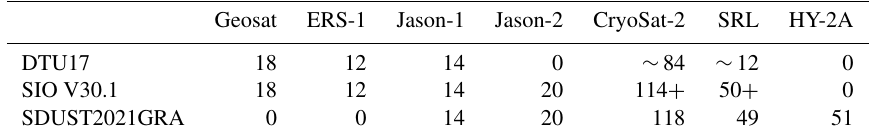
Table 2. Altimeter GM data used for deriving marine gravity anomaly models (unit: month).